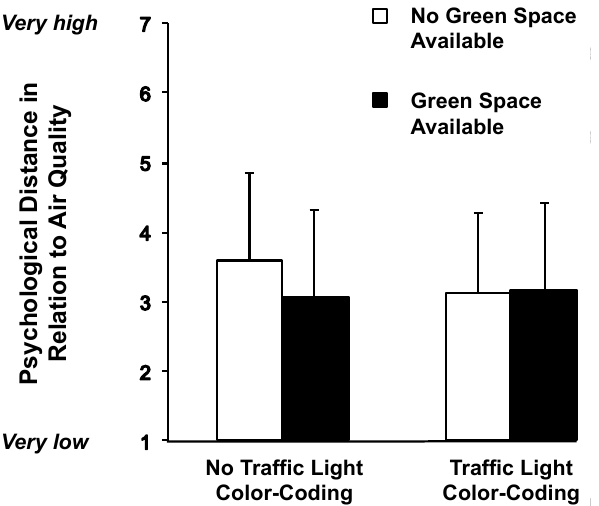
Figure 2. Spatial psychological distance ratings (standard deviations) depending on the availability of green space and the provision of traffic light color-coding of air pollution information on the map.